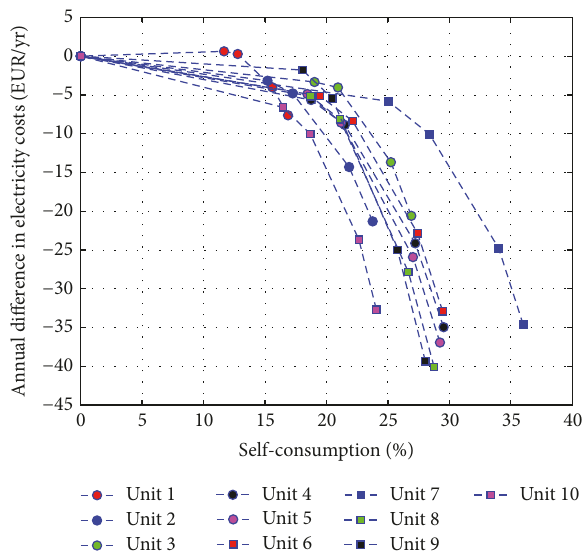
Figure 16: Austrian retail electricity prices, consideration of indi- vidual apartments: annual differences in electricity costs with and without a PV system.